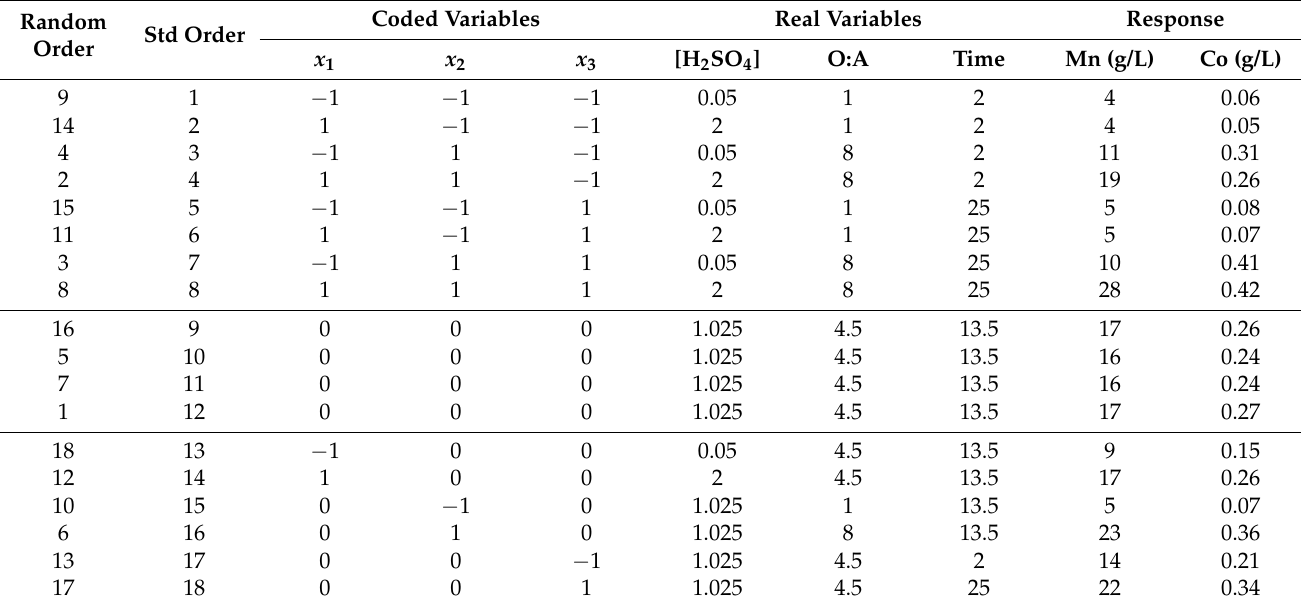
Table 6. Conditions of the experimental design and results for the stripping of cobalt and manganese. Random Std Order